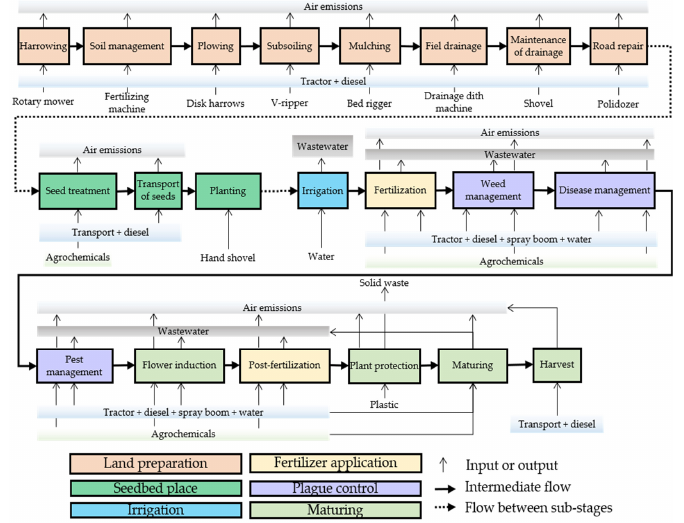
Figure 3. Unit processes that make up the pineapple production stage. Source: own elaboration.